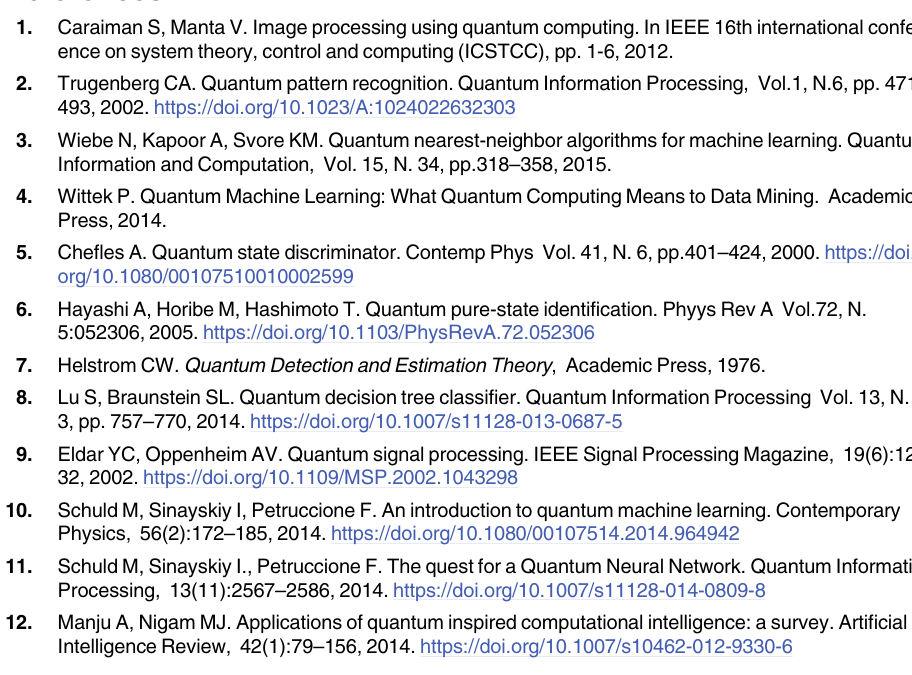
Table L. Analcatdata-boxing2 dataset (with # n number of copies). Table M. Hill-Valley-with- noise dataset (with # n number of copies). Table N. Hill-Valley-without-noise dataset (with # n number of copies). Table O. Average Success